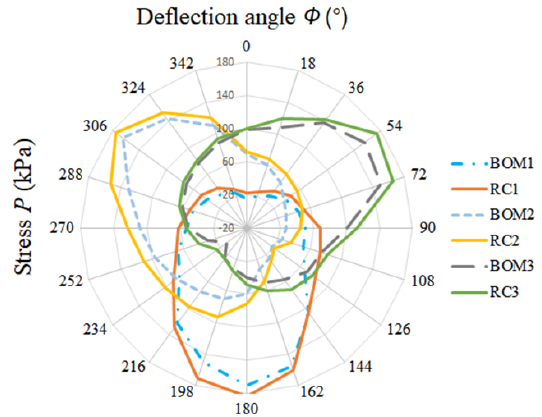
Figure 8. Changeable relation between orientation and stress in CFs. Stress data were collected as the manipulator was bent at different orientations.